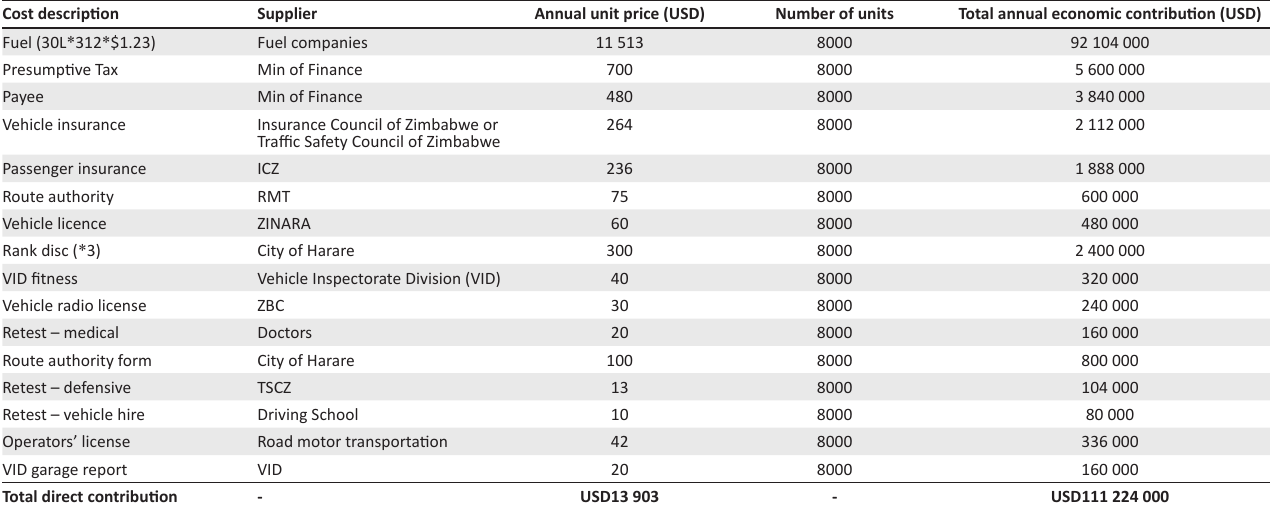
TABLE 6: Estimated contribution of the informal public transport sector to the national budget. Cost